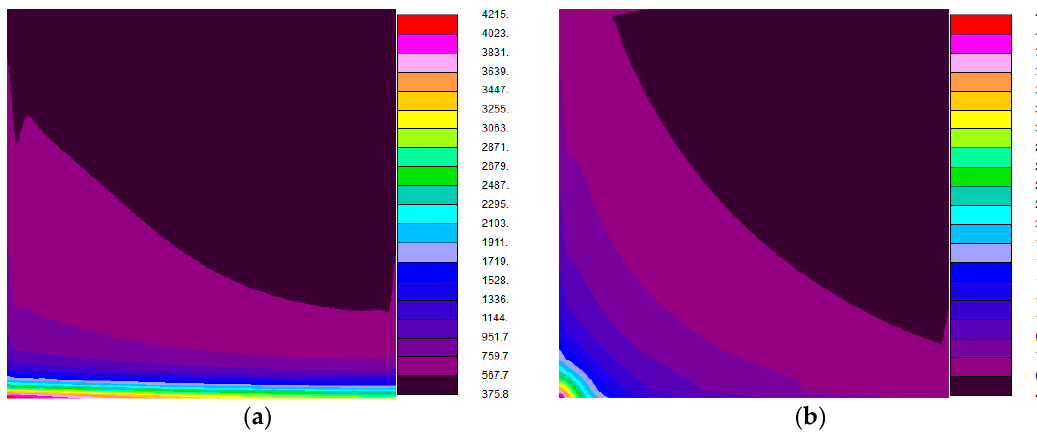
Figure 6. The plate cold side heat flux q c distributions of cross-flow plate heat exchanger ( a ) Heat transfer model with LHC; ( b ) Heat transfer model without LHC. Energies 2018 , 11 , x FOR PEER REVIEW